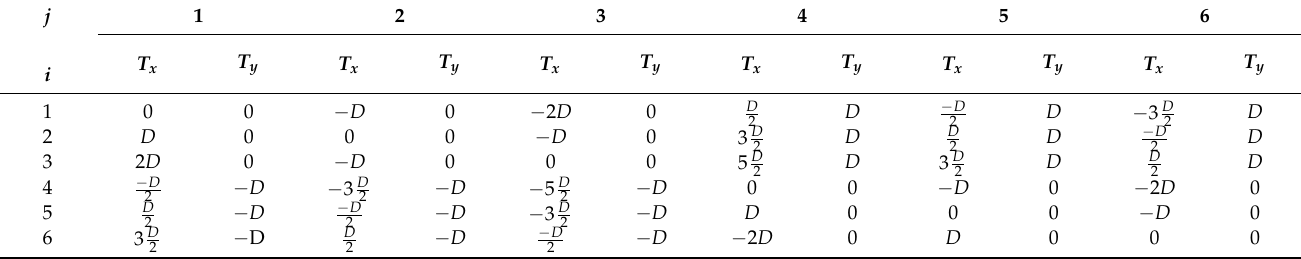
Table 3. Final formation distance in the 12-robot experiment of robots 1–6 for robots